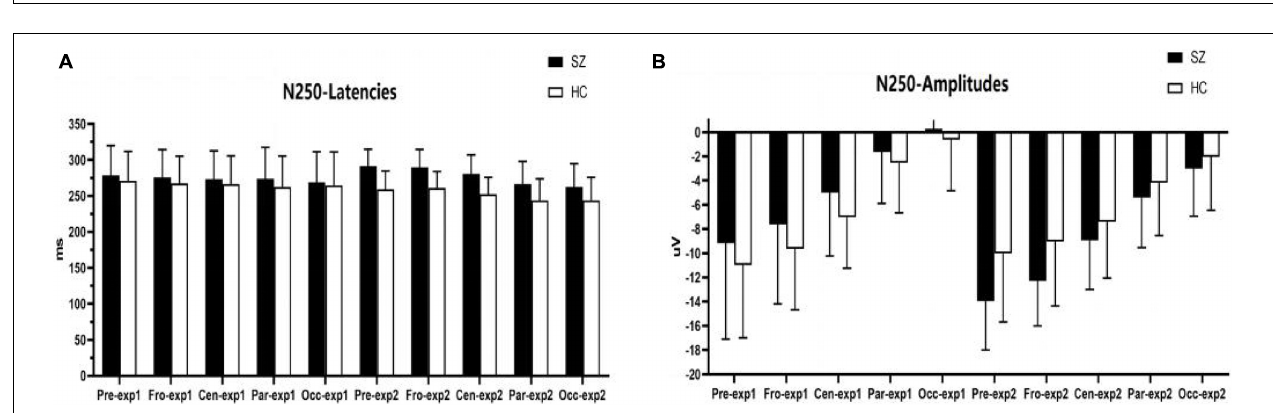
FIGURE 5 | Comparisons of N250 latencies (A) and amplitudes (B) between the schizophrenia group and HC group within sites and experiments. SZ, schizophrenia; HC, healthy control; exp, experiment; Pre, prefrontal, Fro, frontal, Cen, central, Par, parietal, Occ, occipital.